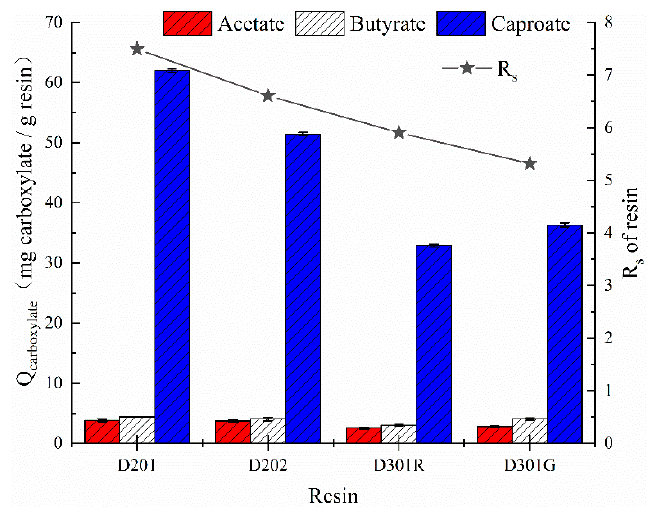
Figure 2. The adsorption capacity (Q carboxylate ) and selectivity (R s ) of resin D201, D202, D301R, and D301G in the simulated fermentation broth. The differences in physicochemical properties between resins are listed in Table 1. The reaction condition is maintained at 30 ± 0.5 °C and pH 7 ± 0.2. Numerical results are the averages with standard deviations of triplicate experiments.